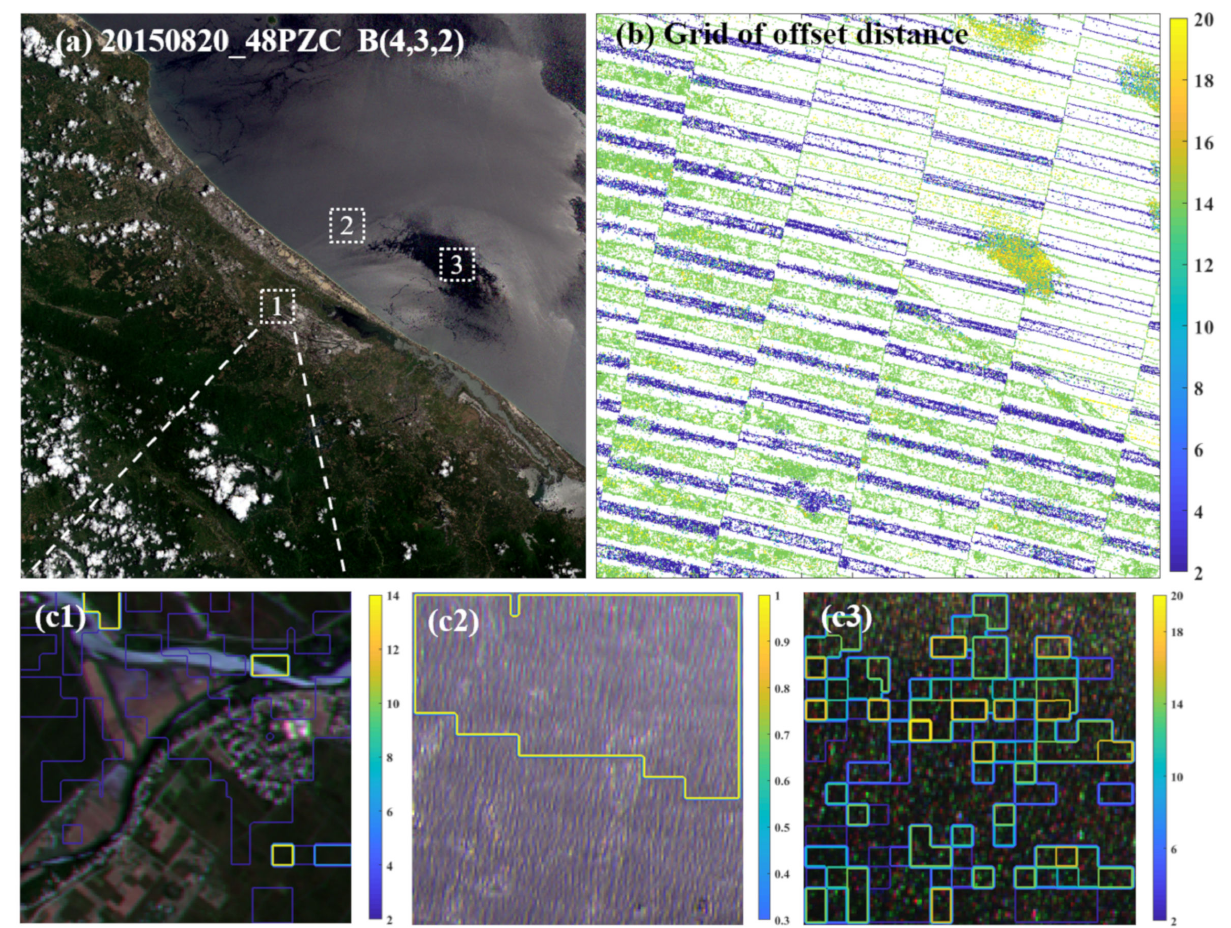
Figure 9. A true-color image with BBMR and the detection result using the phase correlation calculation on a sliding window basis (window size: 16 × 16 pixels, step length: 9 pixels). The result is presented as a grid with a colored border, divided by the inter-band offset distance (pixels) in ( b ). ( c1 – c3 ) The zoom-in image clips (150 × 150 pixels) from the marked areas in the image ( a ) with a contour result